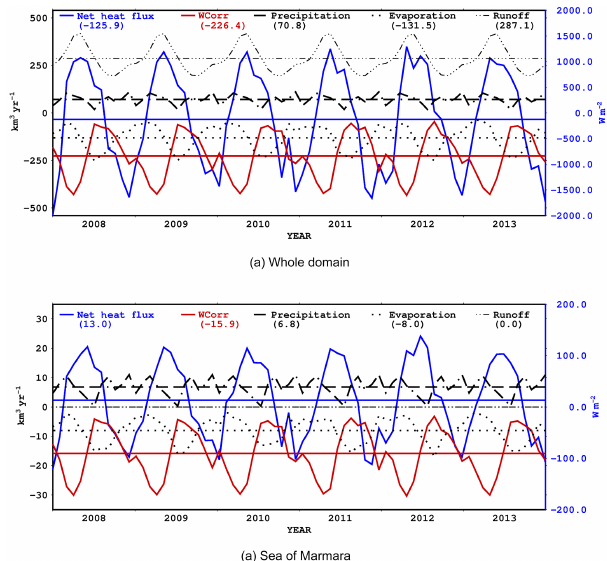
Figure 3. Monthly averaged net heat (blue) and water (black) fluxes in the Sea of Marmara, along with evaporation (dashed) and precip- itation (dotted). Runoff is zero in the Sea of Marmara. The blue vertical axis (right) is for heat flux and the black vertical axis (left) for water fluxes. Water flux correction described in Appendix A is shown in red. The 6-year mean values of fluxes are marked on the figures and shown in legends.